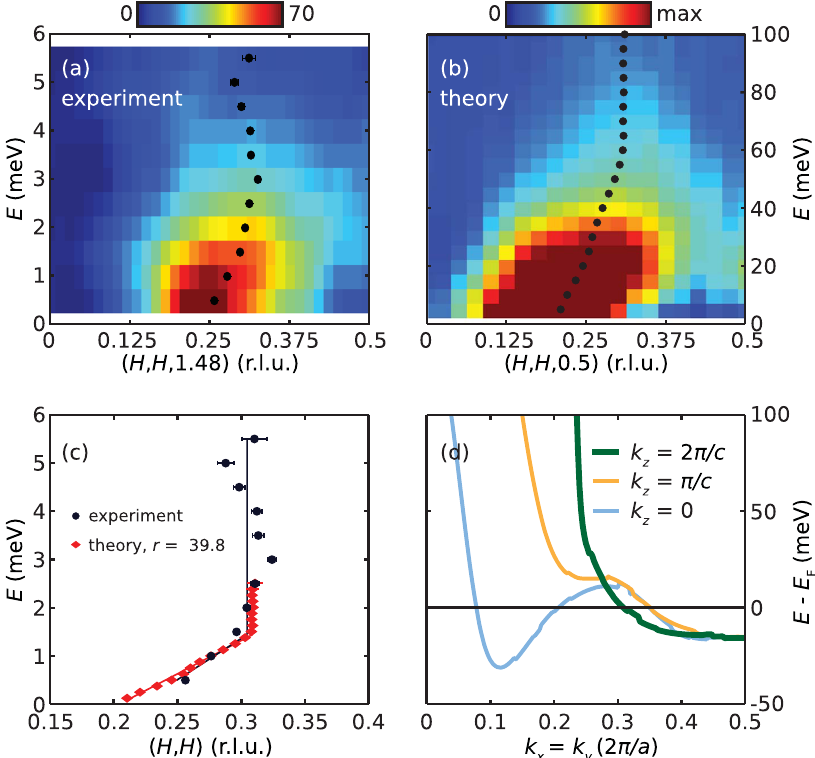
Fig. 3 Dispersion of magnetic excitations in CeCu 2 Si 2 . a Energy-[H, H, 1.48] map at T = 1.6 K obtained by binning data with 1.38 < L < 1.58. b Theoretical energy-[H, H, 0.5] maps obtained from RPA calculations using our LDA + U band structure. c Comparison of experimental and theoretical dispersions, with the theoretical dispersion scaled down by the band renormalization factor r . d Dispersion of electron-like bands along the [ k x , k y = k x , k z ] direction. Data in this fi gure were measured using E = 5 meV. All horizontal error bars are least-square fi t errors of 1